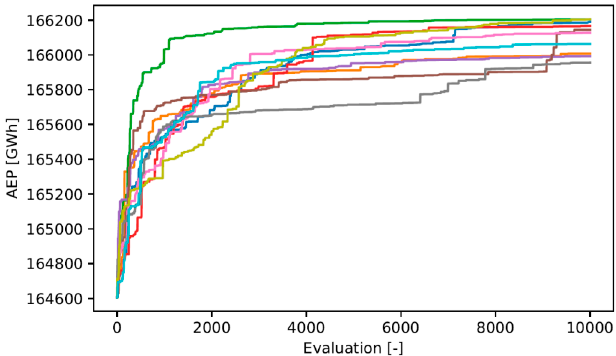
Figure 10. Evolution histories of the 10 Random Search runs under optimization setting: (cid:1831) max = = 5000 m . M 10,000 , (cid:1839) max max = 5000